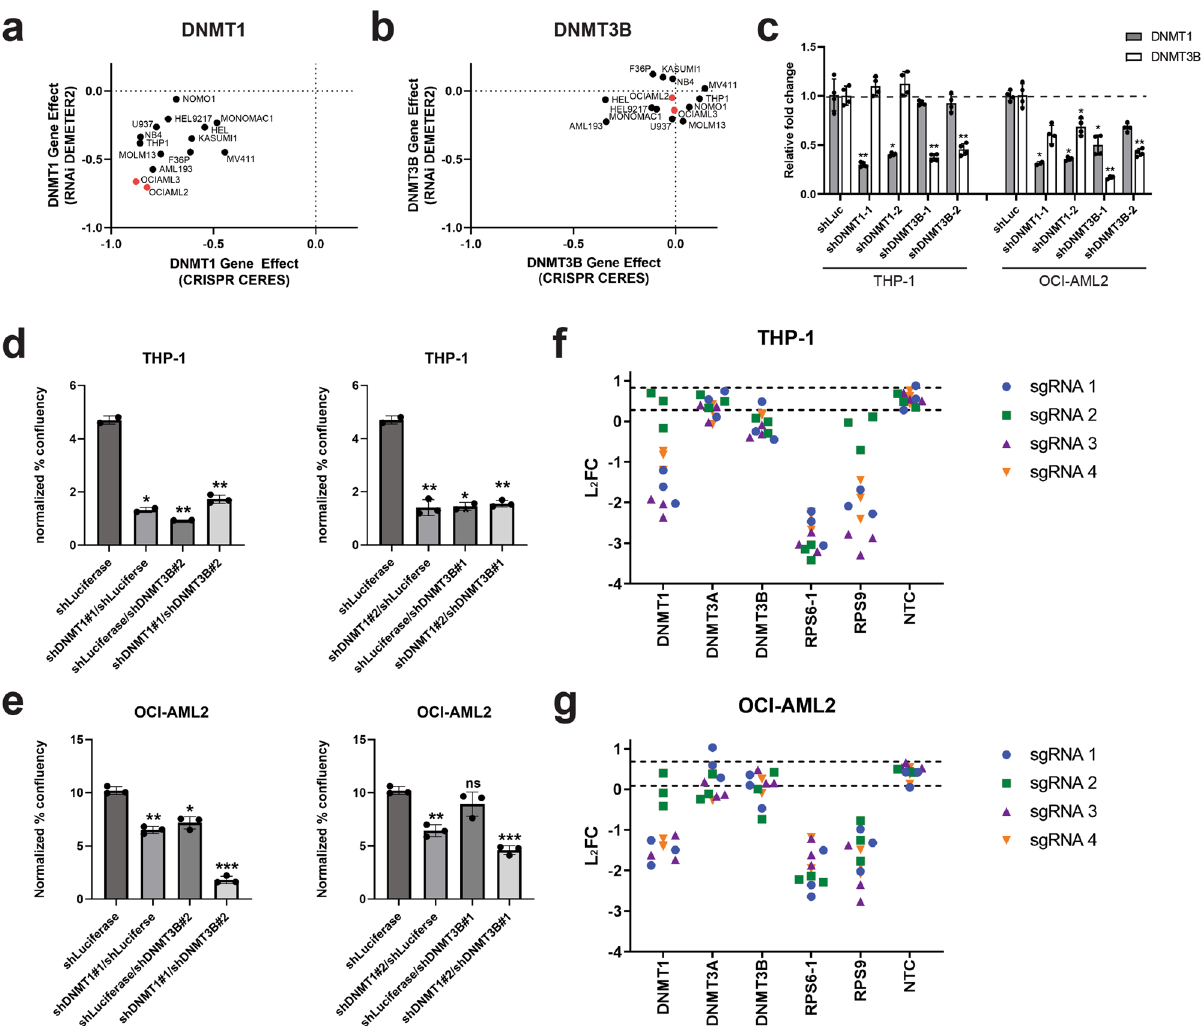
Fig. 1 Knockdown and knockout of DNMT1 inhibits cell proliferation in AML cell lines independent of the mutational status of DNMT3A . a , b RNAi DEMETER2 and CRISPR CERES scores from publicly available AML cell lines targeting DNMT1 ( a ) and DNMT3B ( b ). The DNMT3A mutant AML cell lines, OCI-AML2 and OCI-AML3, are highlighted in red. c Relative transcript levels of DNMT1 and DNMT3B in THP-1 and OCI-AML2 cells transduced with DNMT1 and/or DNMT3B shRNAs. Relative transcript levels were normalized to GAPDH and fold change was calculated relative to cells treated with a shRNA targeting luciferase (shLuc). n = 4; * P < 0.05, ** P < 0.01, Dunnet ’ s multiple comparison test. d , e Spheroid-like growth assays on THP-1 cells, a cell line wild-type for DNMT3A ( d ), and OCI-AML2 cells, which is mutant for DNMT3A ( e ), transduced with DNMT1 and/or DNMT3B shRNAs. Spheroid-like cell con fl uence was normalized to the con fl uence on day 0 of the assay to calculate normalized % con fl uency. n = 3. * P < 0.01, ** P < 0.001, *** P < 0.0001, ns = not signi fi cant, unpaired t-tests. f , g CRISPR/Cas9 pooled screen data for sgRNAs targeting DNMT1 , DNMT3A , and DNMT3B in THP-1 ( f ) and OCI- AML2 ( g ) cells. Four sgRNAs targeting each gene are shown, with experiments being performed in triplicate. RPS6 and RPS9 are common essential genes used as positive controls that affect viability. NTC are non-targeting control guides that should not affect cell growth. The dashed lines represent the mean L 2 FC + / − 2 standard deviations (S.D.) of the non-targeting control sgRNAs included in the